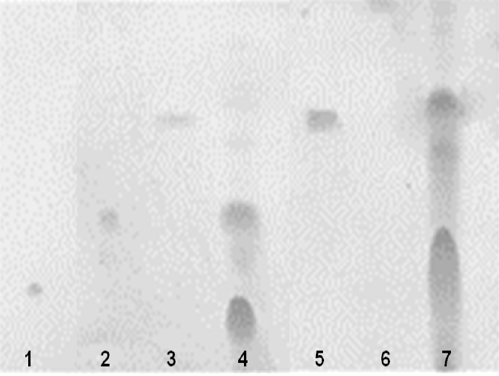
Figure 4. Thin-layer chromatogram of the deconjugation products of bile salts by W. cibaria CMU. 1, cholic acid; 2, chenodeoxycholic acid; 3 and 5, deoxycholic acid; 4, W. cibaria CMU; 6, lithocholic acid; and 7, E. limosum ATCC 8486.